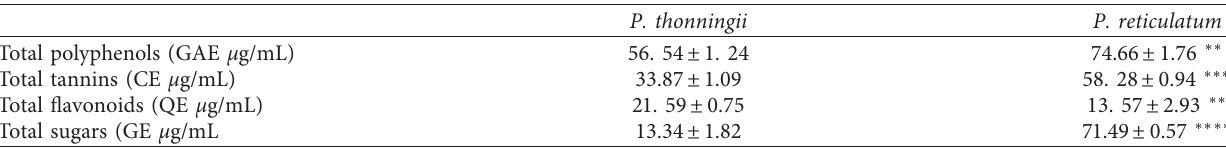
Table 2: The total phenolic-sugar contents in P. reticulatum and P. thonningii methanolic leaves